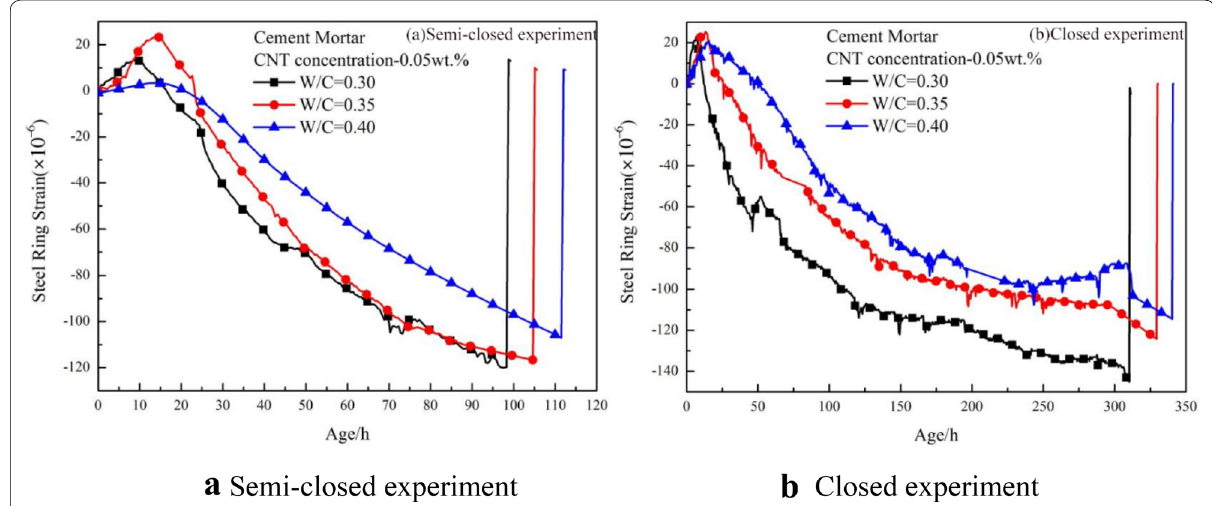
Fig. 7 Cracking strain curve of cement mortar with different water-cement ratios.